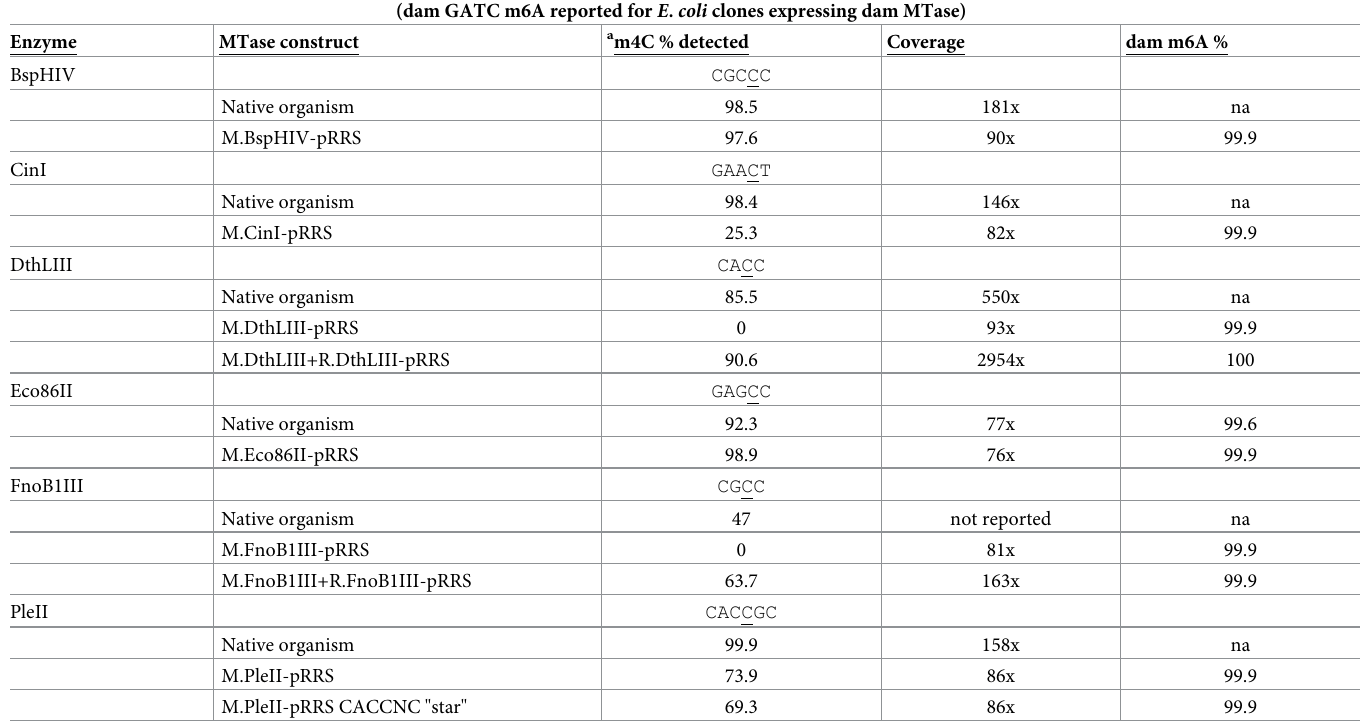
Table 2. Modification detection by SMRT